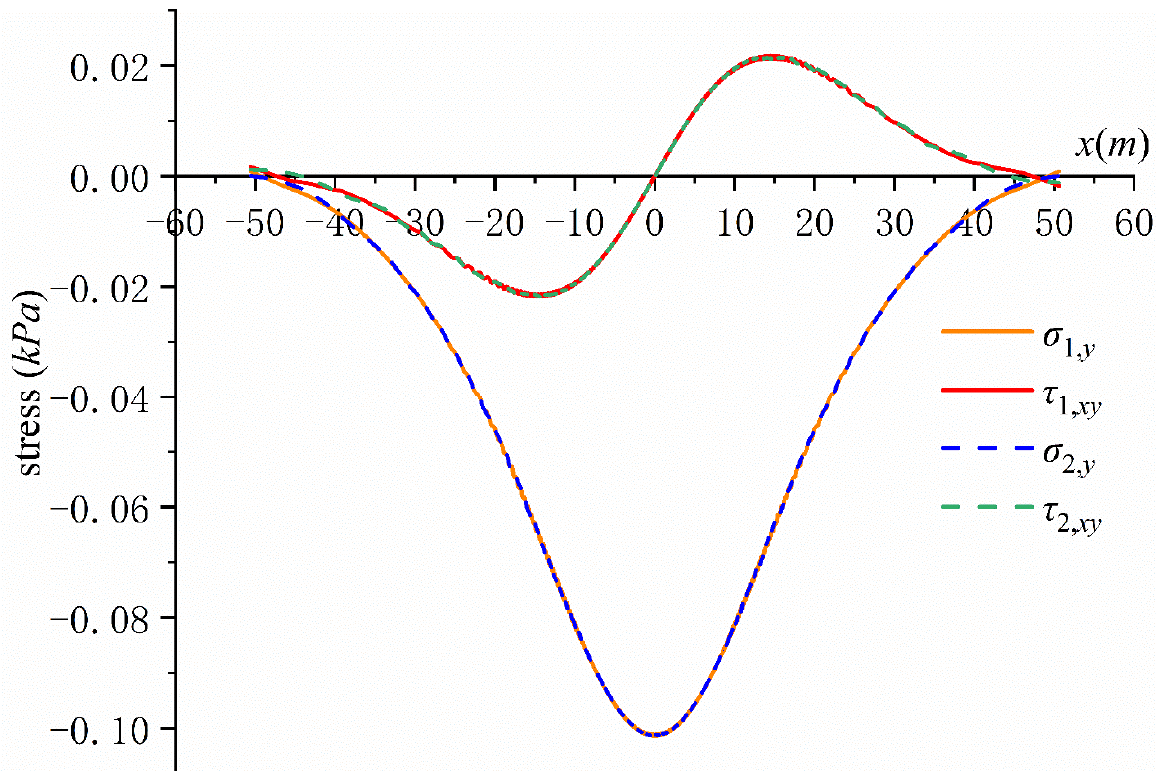
Figure 4. Verification of stress continuity condition.